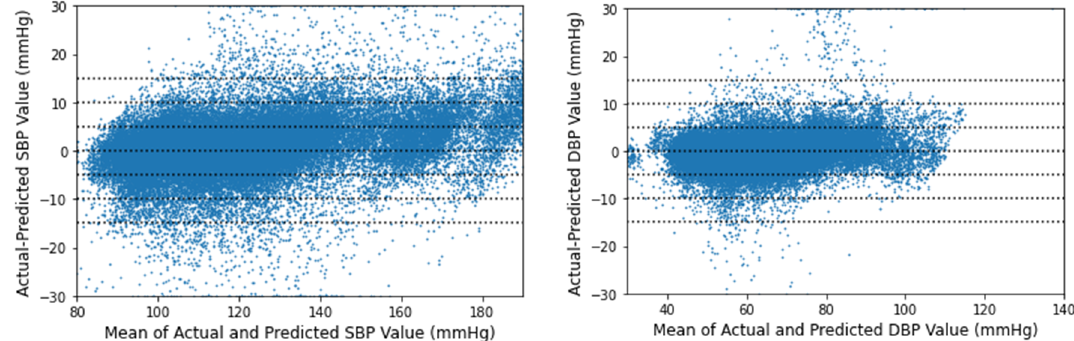
Figure 8. Bland–Altman analysis for real-time SBP and DBP values.